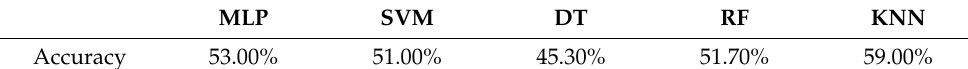
Table 9. Classification results for Dataset 06 (truck driver/office worker).